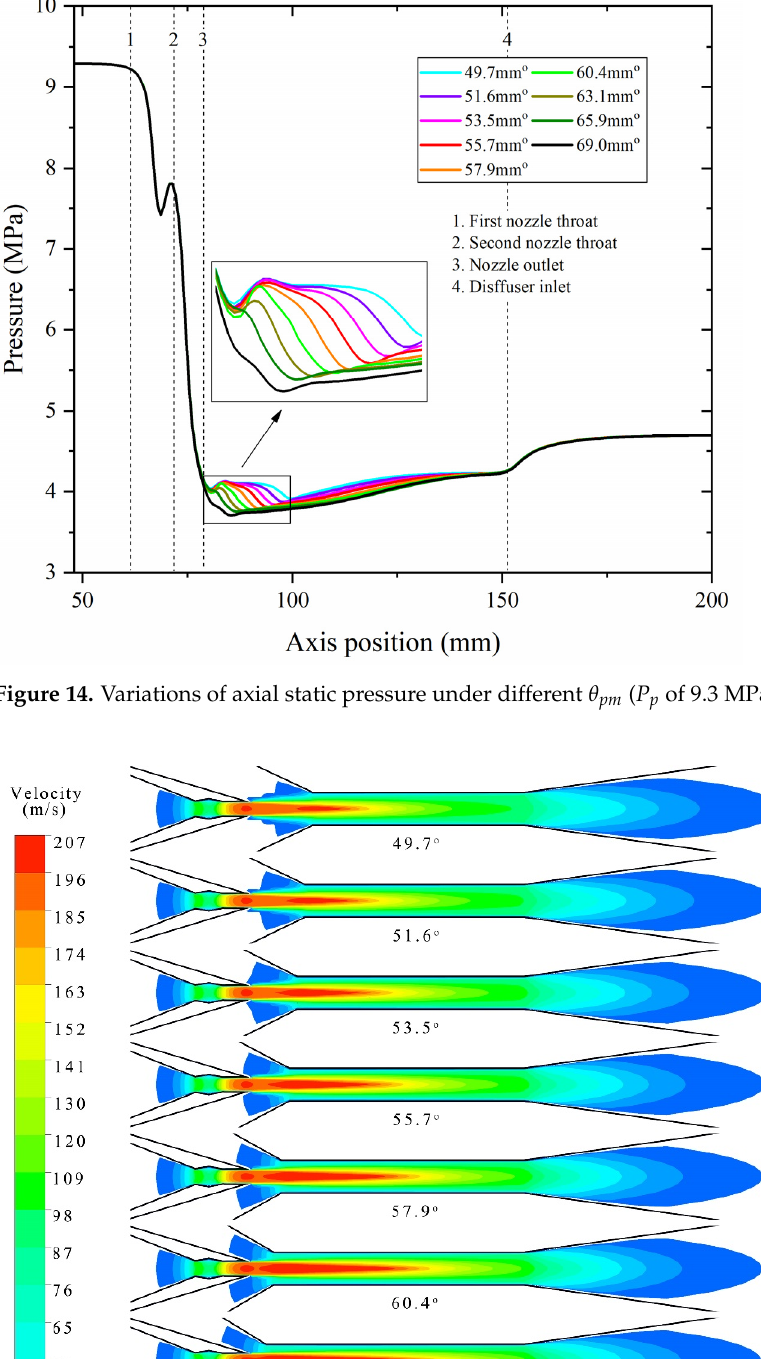
Figure 13. Variations of Er with different θ pm and P p ( D m of 8 mm, L m of 64 mm).